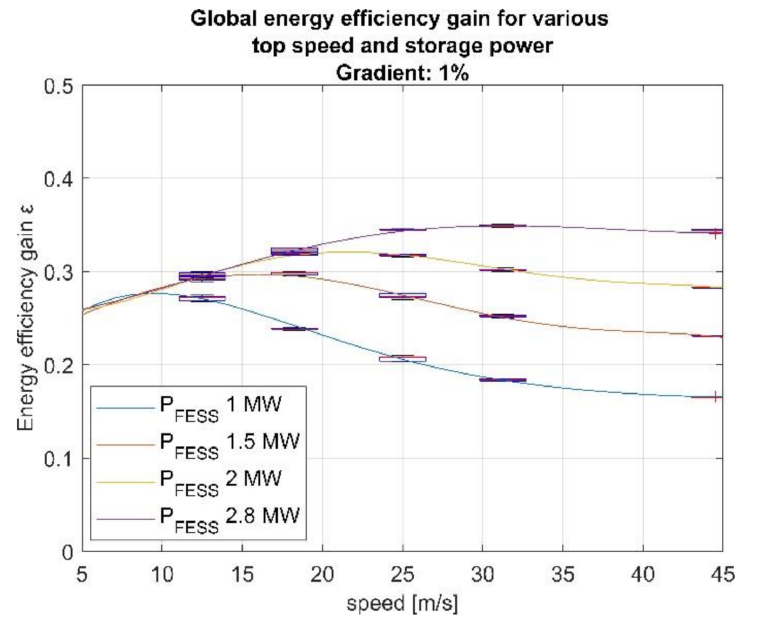
Figure 9. One percent gradient efficiency gain for multiple top speeds and FESS